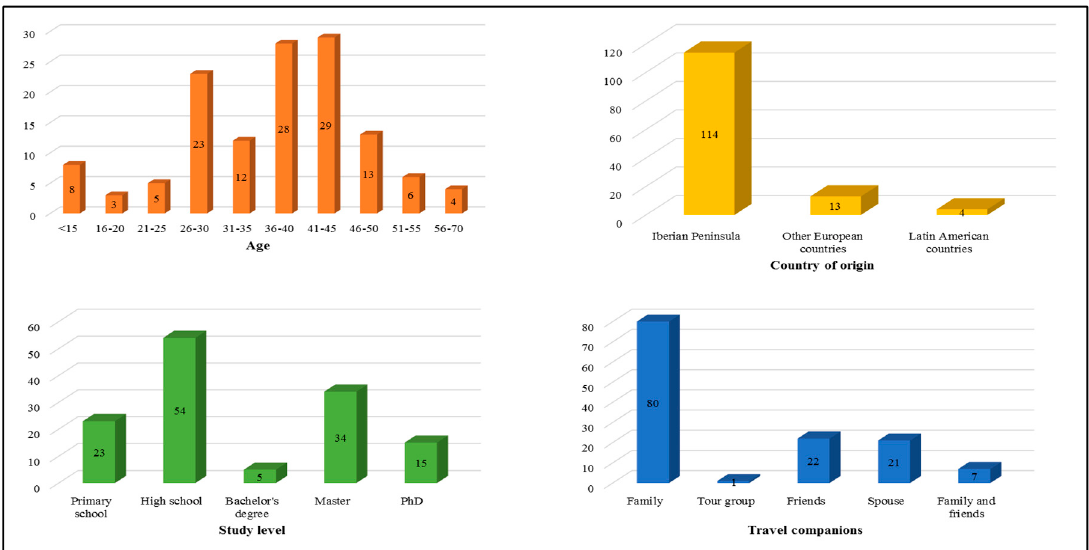
Figure 2. Outputs from camelback riding customer’s qualitative profile frequency analysis.